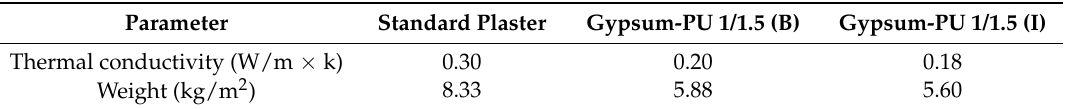
Table 6. Results of thermal conductivity and weight per unit of surface of sample 1/1.5 (B) and 1/1.5 (I).